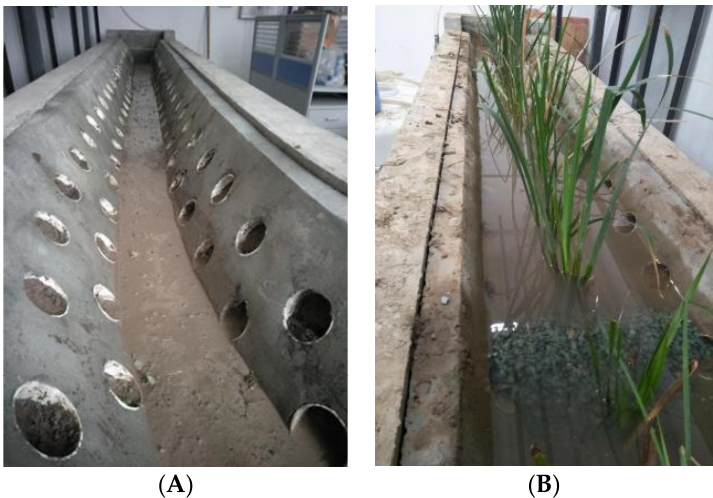
Figure 3. Plant-free soil ditch model ( A ); eco-ditch with plants and matrix dam ( B ).